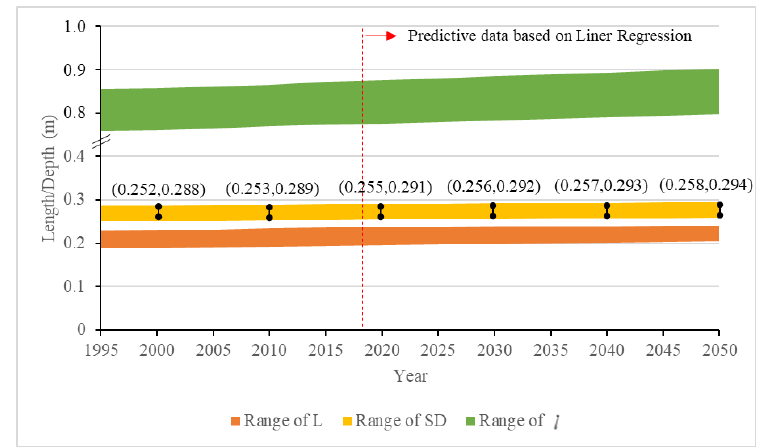
Figure 11. The historical and predictive range of L, SDP and l .